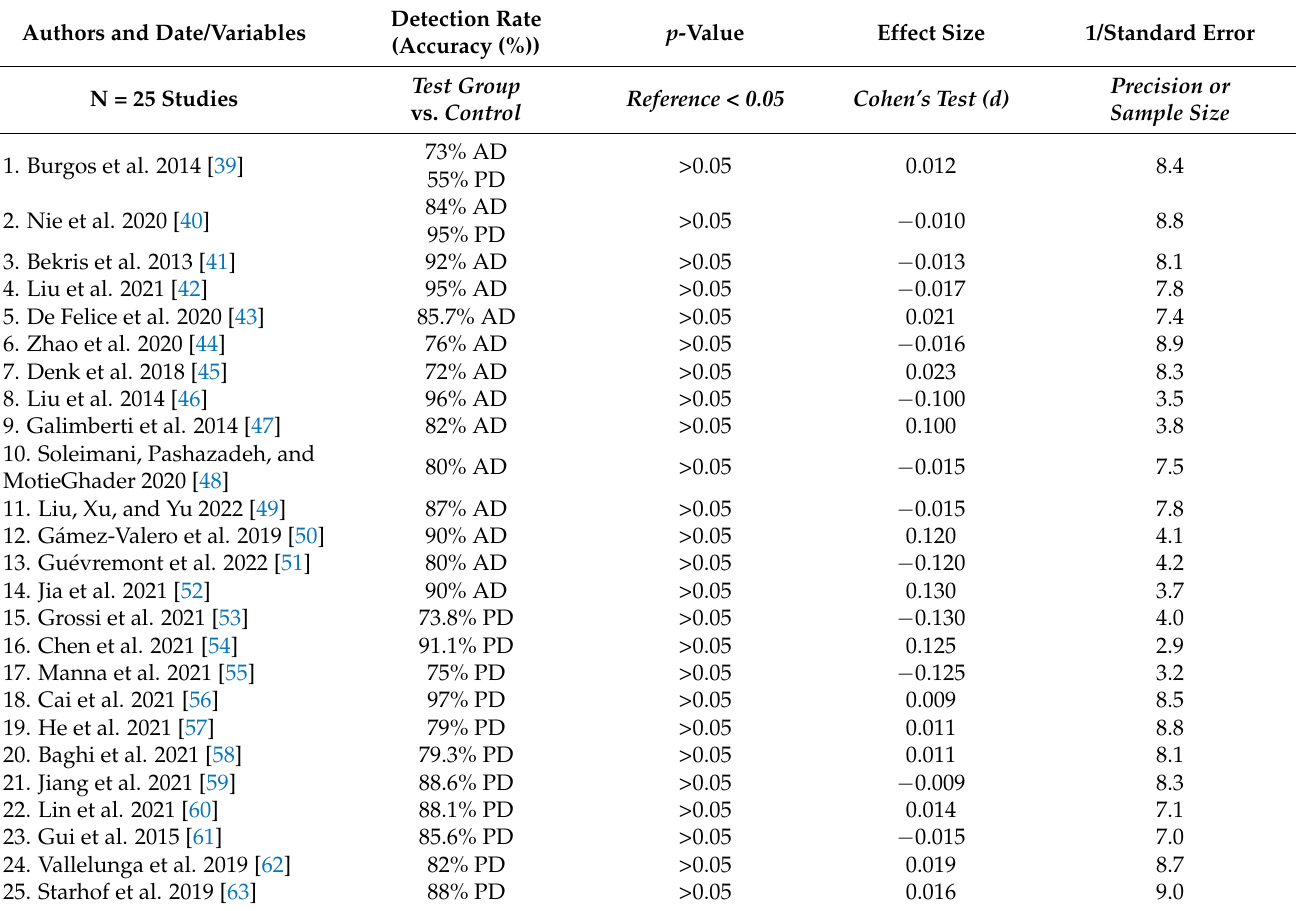
Table 3. Results of the Detection Rate (Accuracy (%) of the identification of miRNAs by qPCR in each selected study.